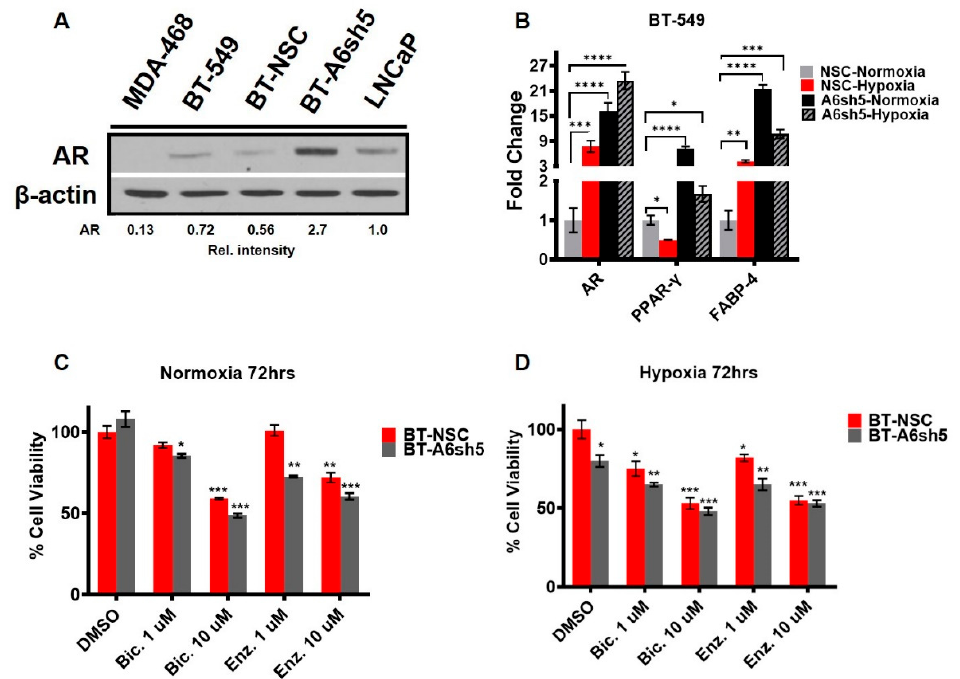
Figure 6. Reduced AnxA6 expression is associated with increased AR expression and sensitivity of TNBC cells to AR antagonist. ( A ) Representative Western blot showing AR expression in MDA-468, BT-549 as well as in control AnxA6 expressing and (NSC), and AnxA6 down regulated (A6sh5) BT-549 cell lines. LNCaP cells were used as the AR-positive control. Detection of β -actin was used as a loading control. ( B ) The effect of AnxA6 expression with or without hypoxia on the expression of AR, PPAR γ , and FABP-4 genes by qRT-PCR. ( C , D ) Effect of AR antagonists bicalutamide (Bic) and enzalutamide (Enz) on the viability of TNBC cells cultured under hypoxia. Cells were seeded in quadruplicate in 96 well plates, then treated with the indicated concentrations of the drugs under normoxia or hypoxia for 72 h. The viability of the cells was assessed by using the PrestoBlue cell viability assay reagent. All data are presented as mean ± SEM, n = 2 . All data are normalized to NSC-DMSO control treatment groups for each cell line. Asterisks (* p ≤ 0.05; ** ≤ 0.01; *** p ≤ 0.001; **** p ≤ 0.0001) indicate significance relative to NSC-DMSO treated cells under normoxia. p- values were analyzed by Two-way ANOVA.